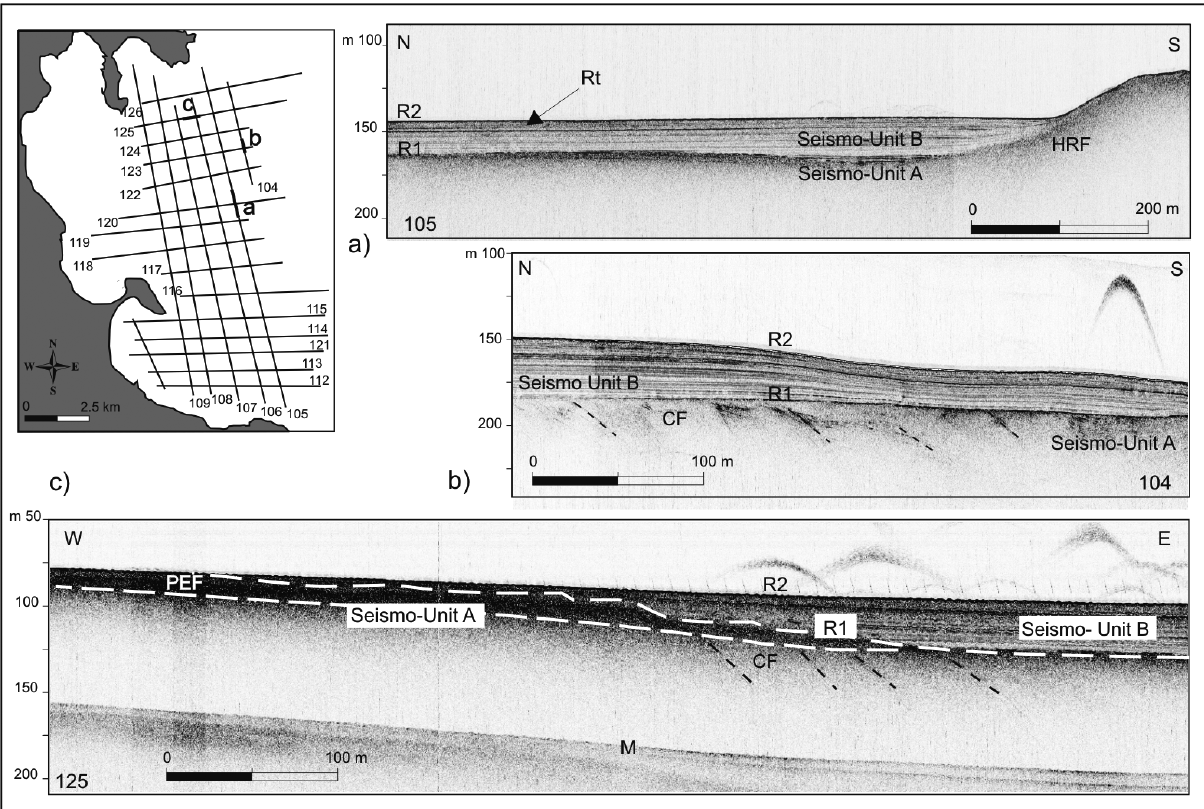
Figure 4. Location of the sections is shown in the profile grid (black lines); seismic lines depicting the seismostratigraphy (the line number is shown at the bottom corners): a) R1 is the main reflector that is the top of the Seismo Unit A here represented by the acoustic bedrock (HRF in the figure); R2 is the top surface of the Seismo Unit B, Rt is the most prominent high-amplitude reflector within the semitrans- parent sedimentary sequence; note the nearly flat surface echoes of Seismo Unit B layers; b) R1 is the top of the Seismo Unit A here rep- resented by the clinoform facies (CF) on which Seismo Unit B rests; c) in this case R1 is the top of both clinoform facies and prolonged echo facies (PEF), representing Seismo Unit A, onlapped by the Seismo Unit B; M =